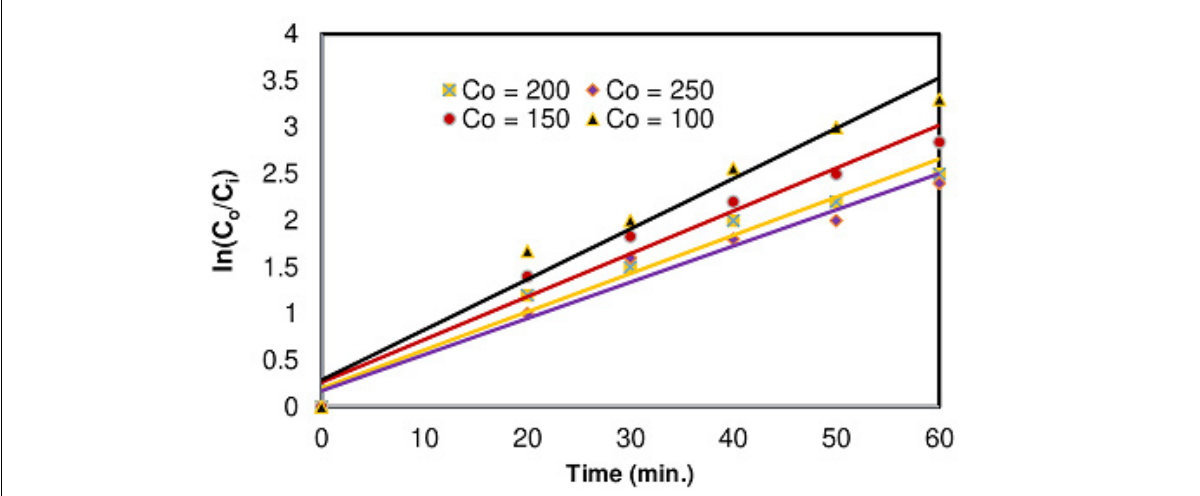
) and chemical oxygen demand (COD). 5